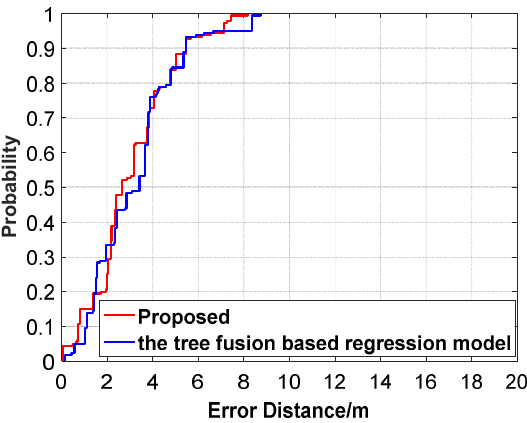
Figure 22. The positioning errors (CDF) between the proposed algorithm and the tree-fusion-based